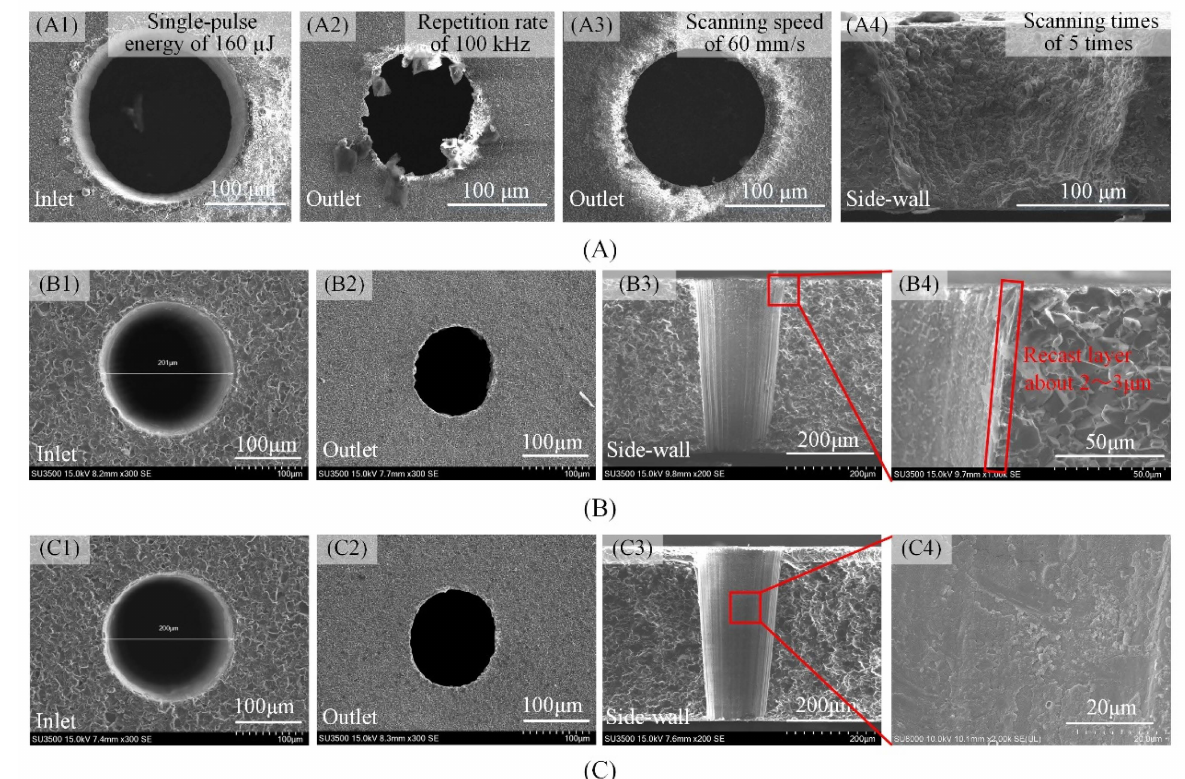
Figure 2. SEM of holes morphology ablated with optimal and non-optimal laser machining parameters in Al 2 O 3 ceramics (( B , C ), 0.38 mm thickness). ( A ) SEM of hole morphology ablated with non-optimal laser machining parameters, ( B ) SEM of hole morphology ablated with optimal laser machining parameters by filled spiral laser trepanning, ( C ) SEM of hole morphology ablated with optimal laser machining parameters by multiple rings laser